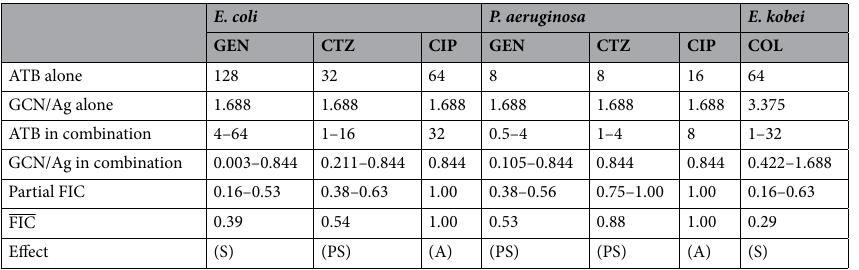
synergetic range, but this was sufficient to raise the average FIC for this combination into the partially synergetic range (Figure S2). Partial synergy against resistant P. aeruginosa was also observed for the pairing of ceftazidime combined with GCN/Ag, whose average FIC of 0.88 was higher than that of gentamicin (0.53) and also higher than that for ceftazidime when used against E. coli (0.54). However, even in this case, with partial FICs ranging from 0.75 to 1.00, combined treatment with 0.844 mg/L GCN/Ag reduced the ceftazidime concentration needed to kill resistant P. aeruginosa by a factor of four. The FIC index for the combination of ciprofloxacin with the GCN/Ag nanohybrid when tested against P. aeruginosa was 1.0, indicating an additive effect with no significant improvement in antibacterial activity; this is consistent with the results obtained for ciprofloxacin when used against resistant E. coli. The MIC of the GCN/Ag nanohybrid against colistin-resistant E. kobei was 3.375 mg/L. Combined treatment